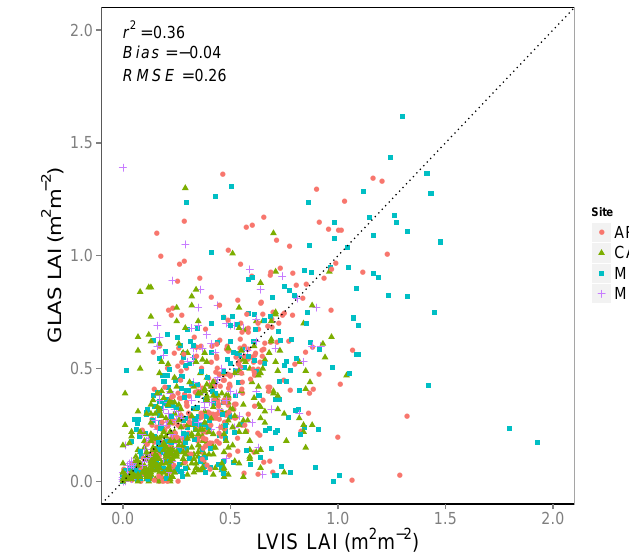
Figure 1. A comparison between two lidar-derived leaf area index (LAI) data sets at different sites across the US ( N = 318), produced from the Laser Vegetation Imaging Sensor (LVIS) and the Geo- science Laser Altimeter System (GLAS), respectively. Each point represents a comparison at the GLAS footprint, while different col- ors and shapes indicate different sites (AR: White River National Wildlife Refuge in Arkansas; CA: Sierra National Forest in Califor- nia; MD: Baltimore–Washington corridor in Maryland; ME: Maine forests to the north of Orono, Maine). The comparison produces r 2 of 0.60, bias of − 0.23, and RMSE of 0.82). Dashed line is the 1 : 1 line.